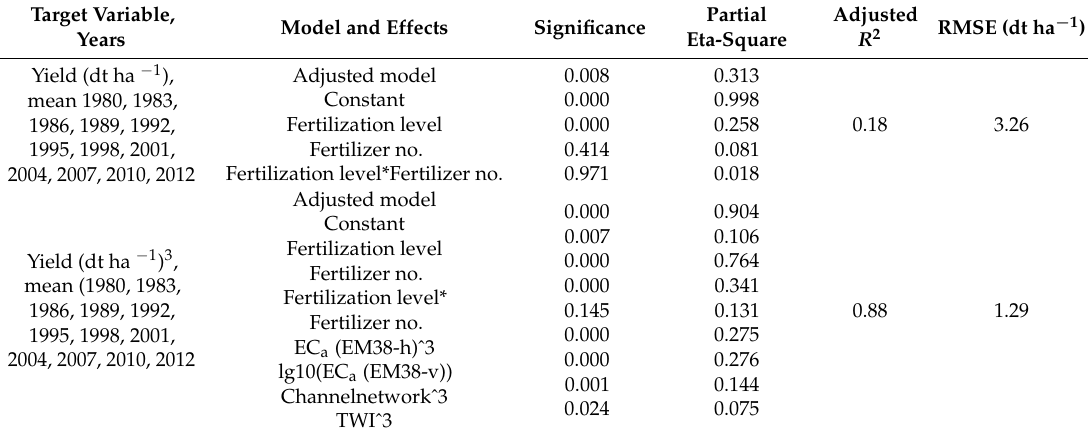
Table 9. Simulation of the yield (1980–2012) with ANOVA and ANCOVA with the factors fertilizing level and fertilizer-no. and the covariates ECa and relief